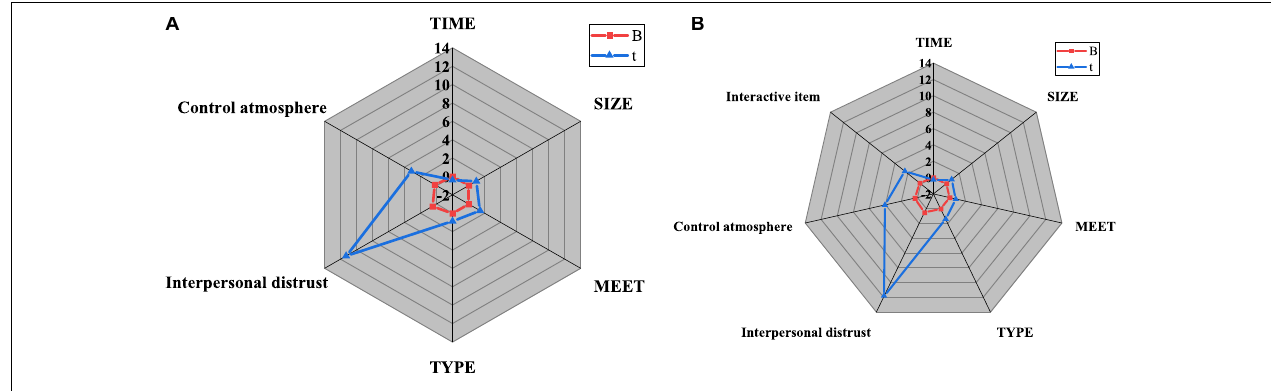
FIGURE 15 | Mediating effect of control atmosphere on interpersonal mistrust and temporary team performance. (A) Regression model 1; (B) Regression model 2.